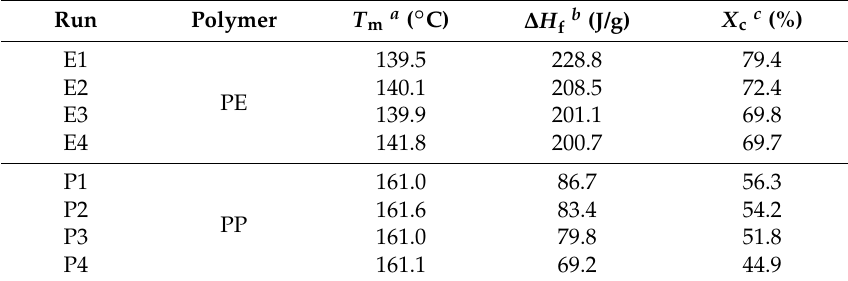
Table 3. Thermal properties of nascent polymer particles.